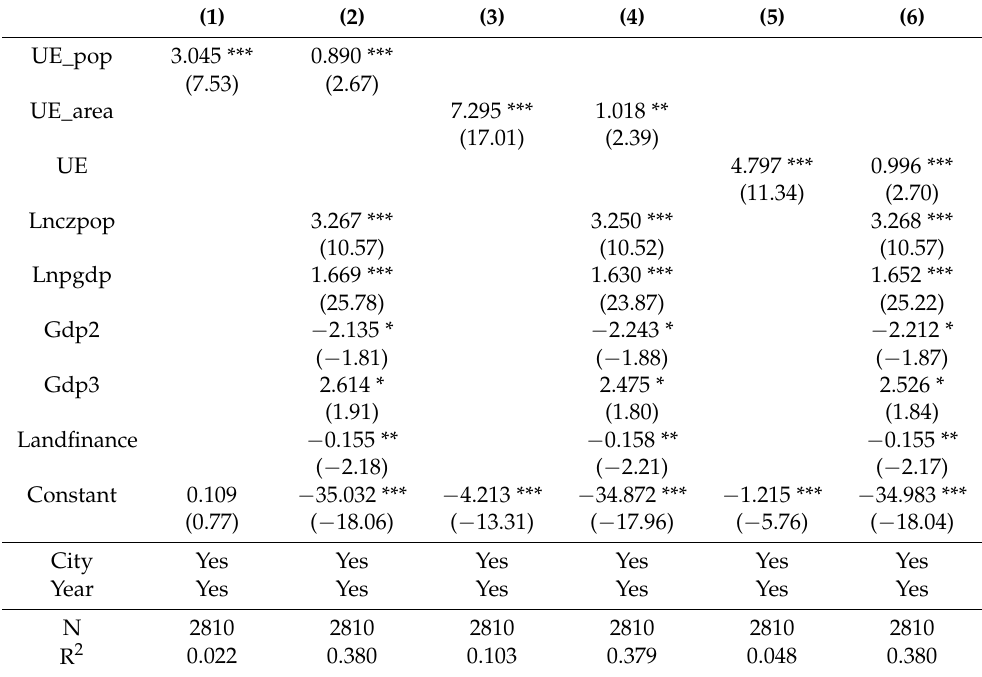
Table 3. Benchmark regression